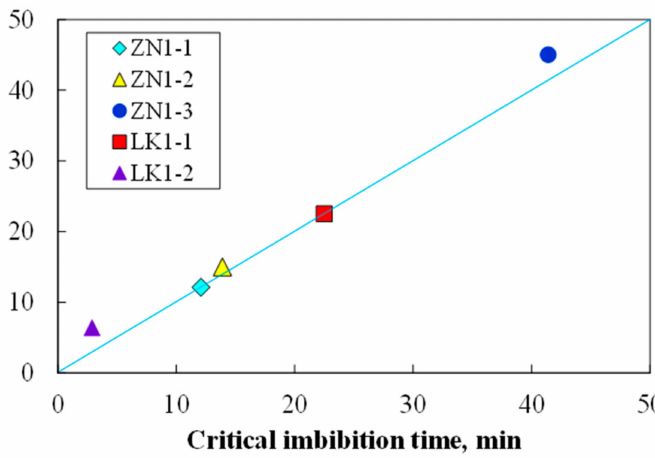
Figure 10. Relationship between critical imbibition time and fracture initiation